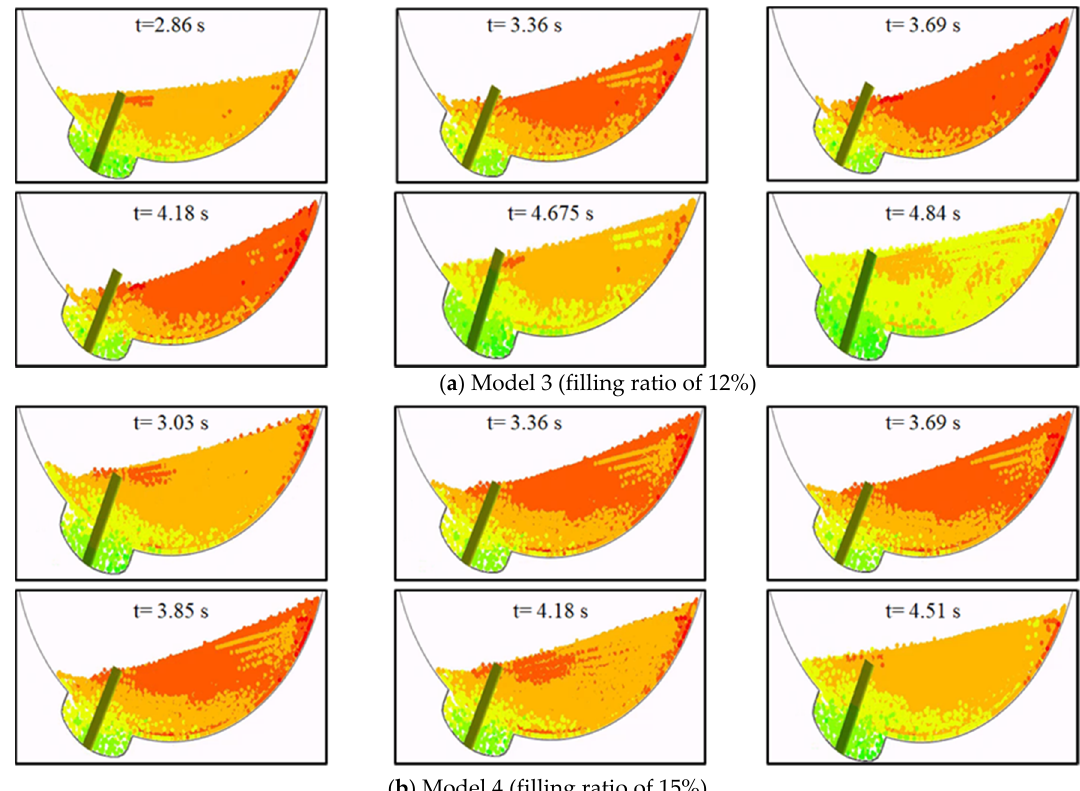
Figure 8. Flow snaps in each cycle of Model 3 under rolling condition.